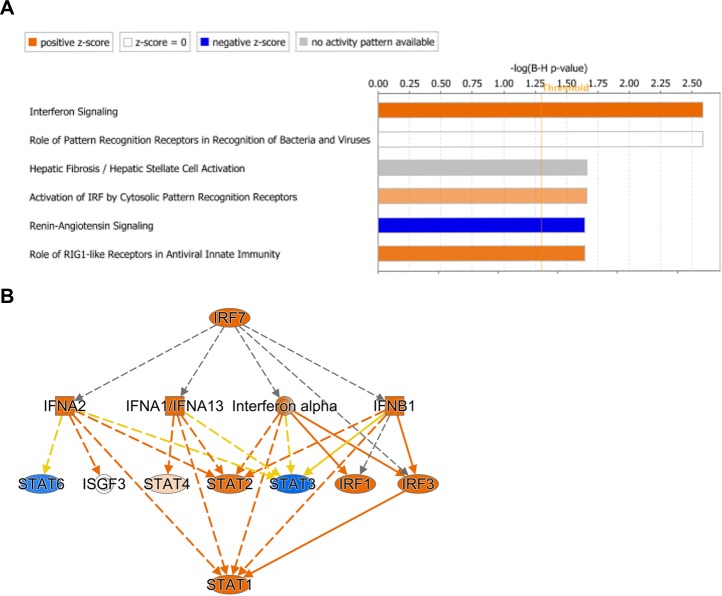
Features of the Defense Response, including Interferon Signaling and IRF Activation, are predicted to have increased activity in the 12 week old Atxn1154Q/2Q KI inferior olive.(A) Biological pathway enrichment using Qiagen’s IPA in the 12 week old Atxn1154Q/2Q KI inferior olive differentially expressed genes. X-axis marks the enrichment score using a Benjamini-Hochberg corrected p-value. Bars that surpass the vertical threshold at 1.3 indicate significant enrichment for that pathway. Orange coloring indicates IPA-predicted activation of that pathway, while blue suggests possible inhibition based on z-score. Grey is not predicted. (B) Predicted upstream regulators for all differentially expressed Atxn1154Q/2Q KI inferior olive genes at 12 weeks. Orange nodes indicate predicted activation of those transcriptional regulators, blue indicates predicted suppression, and grey has no predicted activation or inhibition. Orange edges connecting transcriptional regulators indicate predicted activation, yellow are findings inconsistent with previous research, and grey is not predicted.